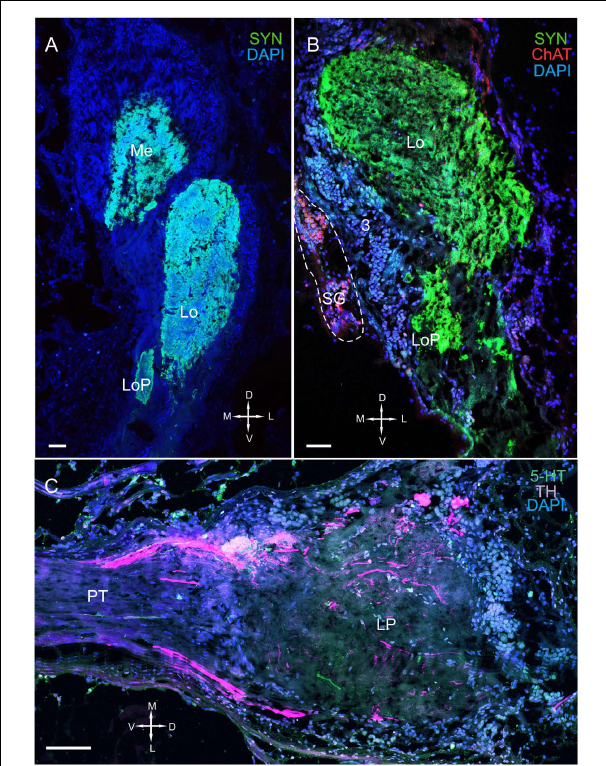
FIGURE 2 | Immunolabeled optic neuropils, SG, and lateral protocerebrum. Regions were labeled with DAPI (blue) and anti-SYN (green) or anti-5-HT, anti-ChAT (red), and anti-TH (magenta). (A) Dorsal view of SYN-positive immunostaining in the Me, Lo, and LoP. (B) Ventral view of immunolabeled SYN- and ChAT-positive immunostaining in the Me, Lo, and LoP. (C) Tissue section displaying high TH immunostaining in the LP adjacent to the PT. Dashed line in panel (B) indicates cells of the SG. Scale bars = 100 µ m. Me, medulla; Lo, lobula; LoP, lobula plate; LP, lateral protocerebrum; OT, optic tract; PT, protocerebral tract; SYN, synapsin; D, dorsal; V, ventral; L, lateral; M,